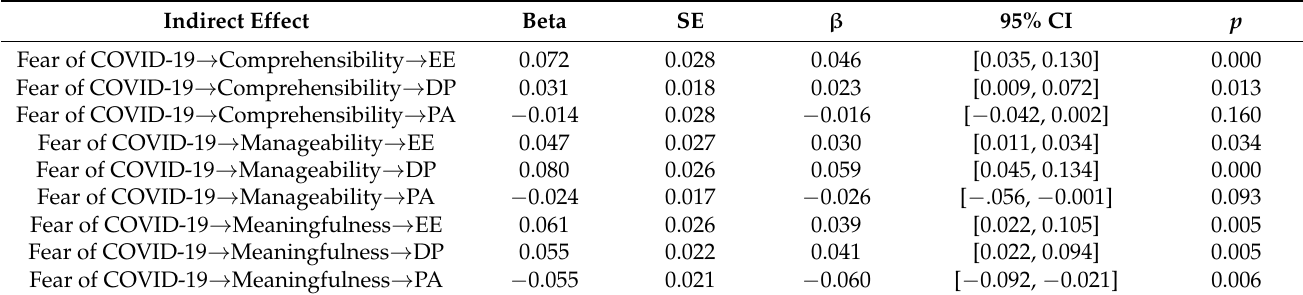
Table 3. The indirect effects of fear of COVID-19 on indices of